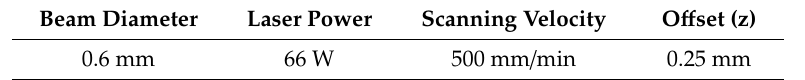
Table 1. The process parameters for DED (Direct Energy Deposition) of TNM TM (Ti-Nb-Mo)